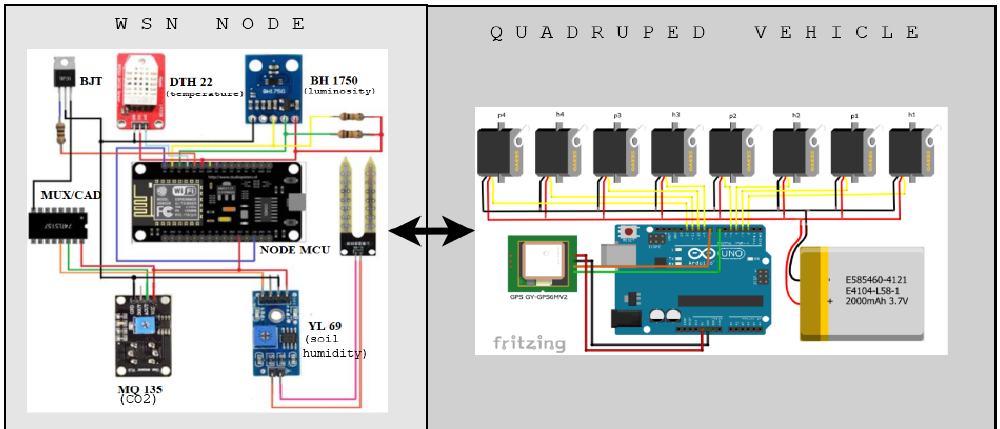
Figure 1. Schematic diagram of the proposed embedded systems for both the wireless sensor network (WSN) node (left side) and the quadruped vehicle